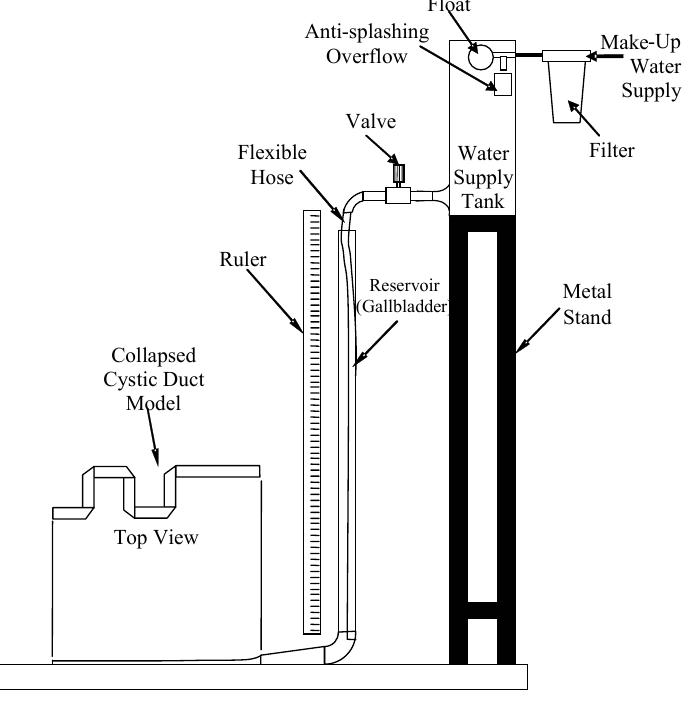
Fig. 4 Experimental set-up to study the compliant cystic duct